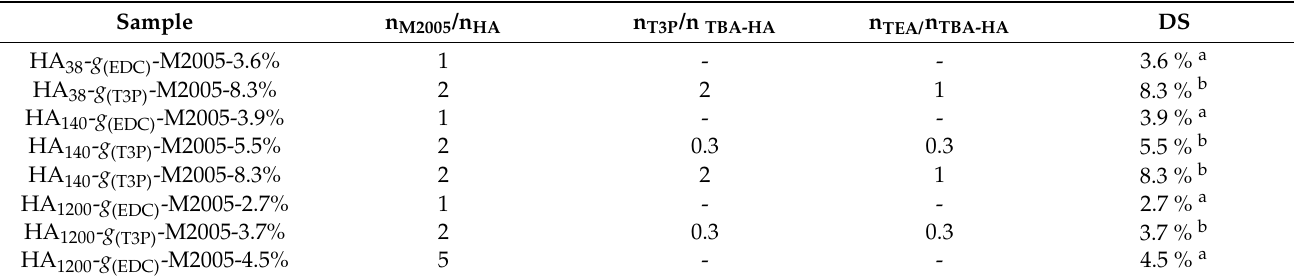
Table 1. Reaction conditions and resulting grafting degrees and molar mass of the different HA-g-M2005. EDC/NHS were used with a ratio of 1/0.04 compared to Na-HA